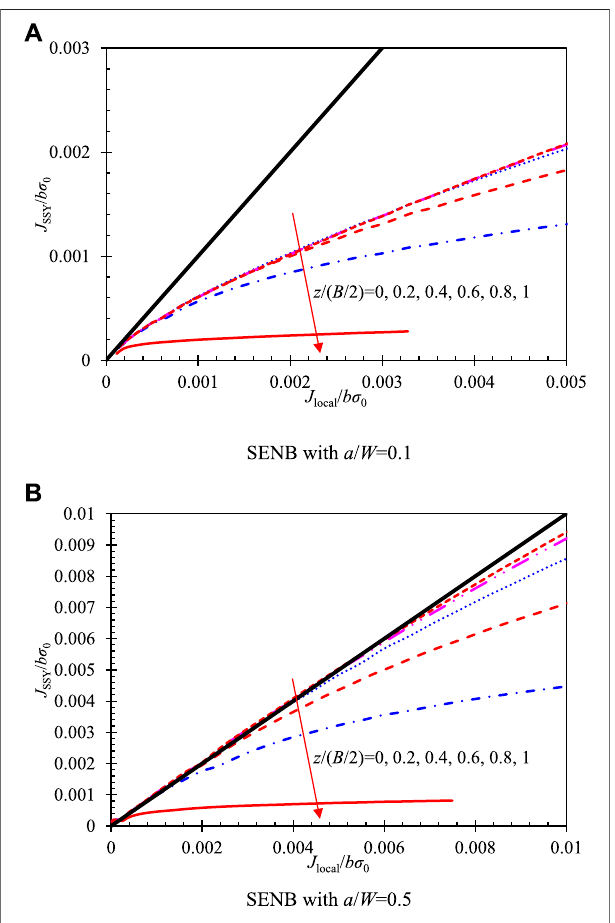
FIGURE 7 | Fracture toughness scaling relationship for SENB specimens on the 2D SSY model. (A) SENB with a / W = 0.1. (B) SENB with a / W = 0.5.